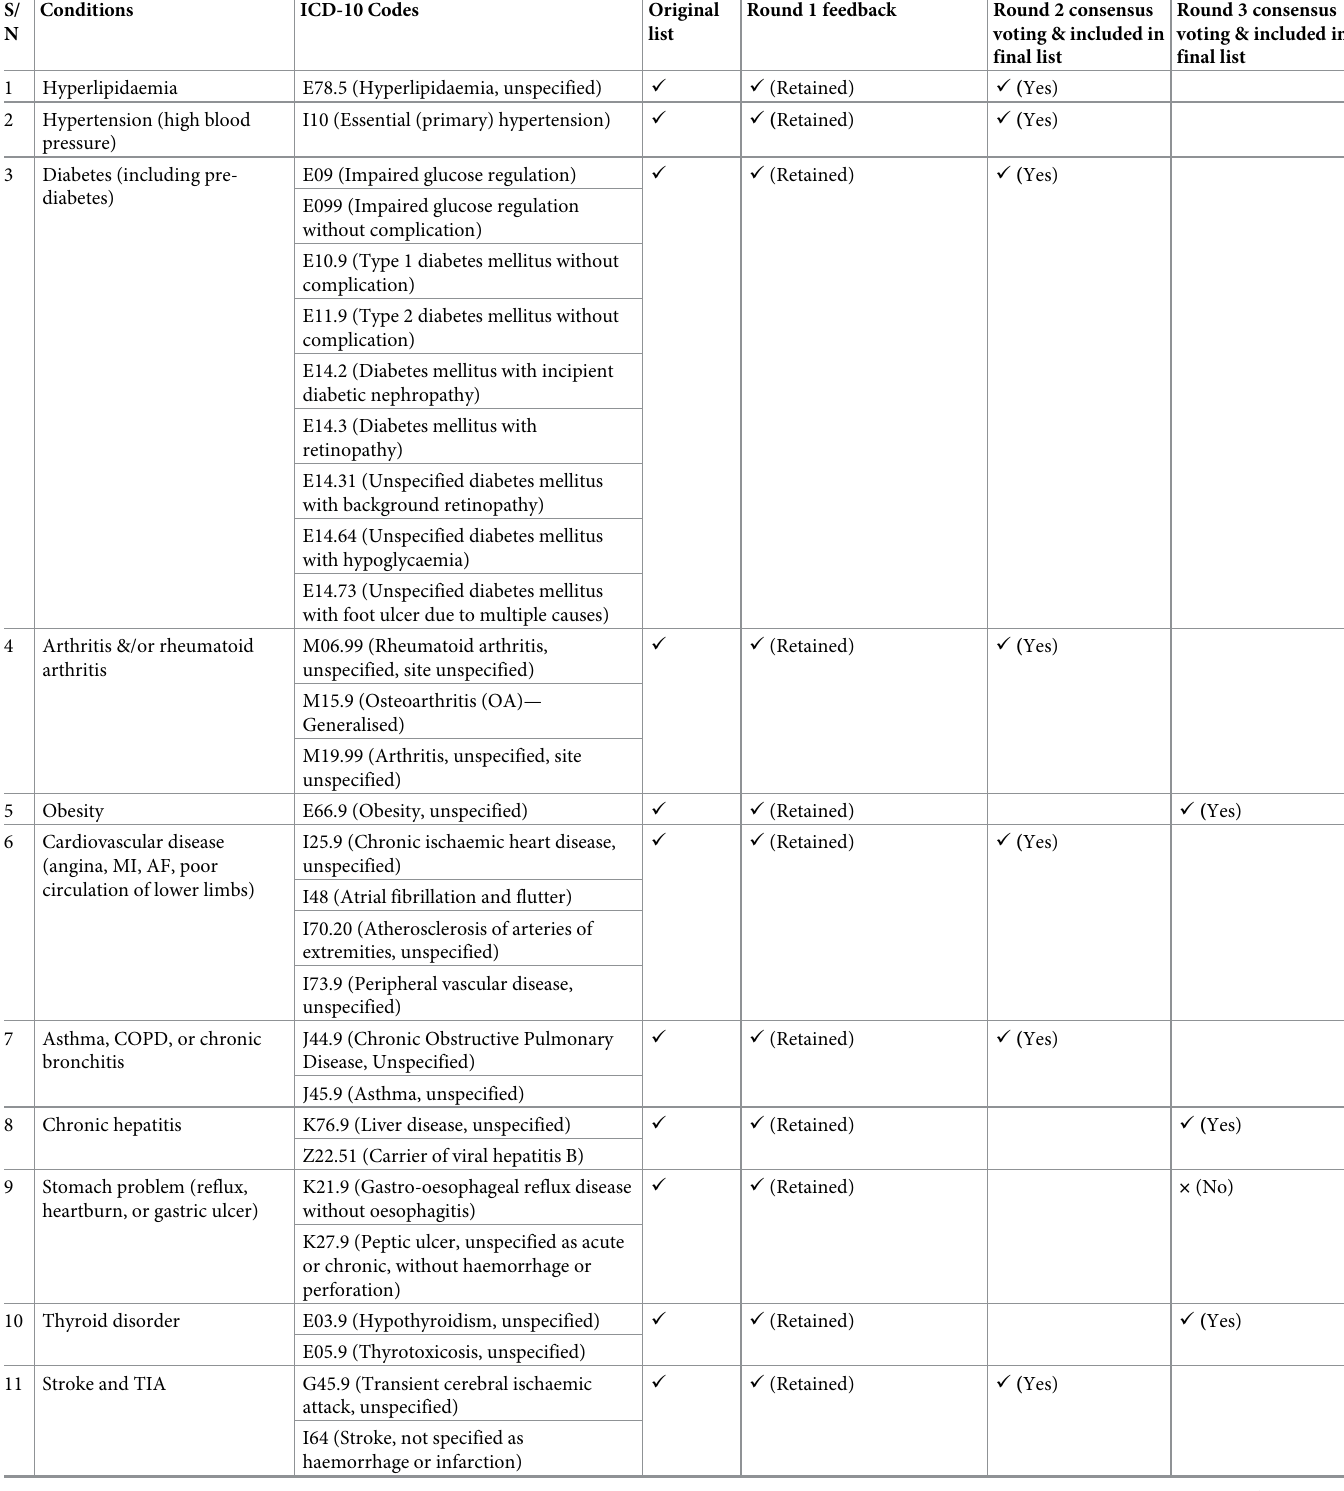
Table 6. The consolidated findings for list of conditions across Delphi rounds 1 to